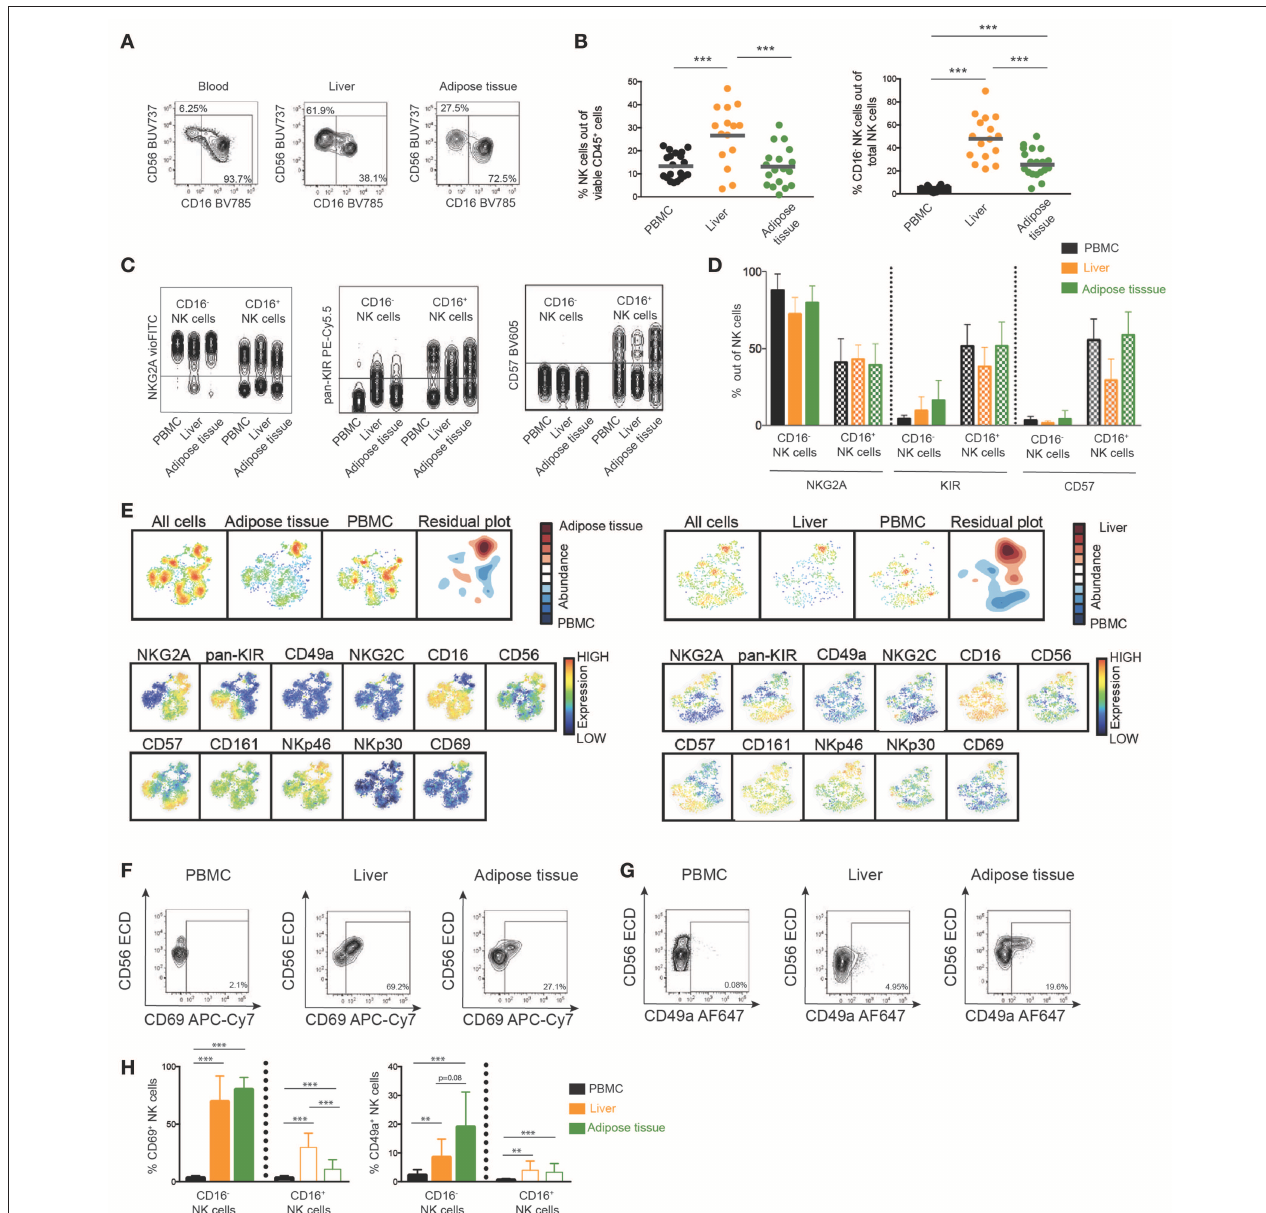
FIGURE 4 | Phenotype of NK cells in liver and adipose tissue. (A) Representative flow cytometry plots of NK cells derived from blood, liver, and adipose tissue. (B) Scatter plot of the frequency of total NK cells out of viable leukocytes and CD16 − NK cells out of total NK cells in peripheral blood, liver, and adipose tissue. PBMC ( n = 22), adipose tissue ( n = 19), and liver ( n = 15). (C) Representative concatenated flow cytometry plots showing expression of differentiation markers NKG2A, KIRs, and CD57 on CD16 − or CD16 + NK cells in blood, liver, and adipose tissue. (D) Bar graphs showing frequency of cells expressing the indicated differentiation markers in CD16 − or CD16 + NK cells from blood, liver, and adipose tissue. PBMC ( n = 22), adipose tissue ( n = 19), and liver ( n = 15). (E) SNE plot of total NK cells from adipose tissue (left) or liver (right) compared to peripheral blood. The residual plot highlights the decreased (blue) or more highly expressed (red) areas within tissue NK cells. (F,G) Representative flow cytometry plots showing CD69 and CD49a expression on total NK cells from the indicated tissues. (H) Expression of CD69 and CD49a on CD16 − and CD16 + NK cells in peripheral blood, liver, and adipose tissue. In H, CD69 on PBMC ( n = 22), adipose tissue ( n = 18), and liver ( n = 15), CD49a on PBMC ( n = 9), adipose tissue ( n = 9), and liver ( n = 7). Bars in (B,D,H) represent mean and error bars in (D,H) show SEM. ** p < 0.01, *** p <